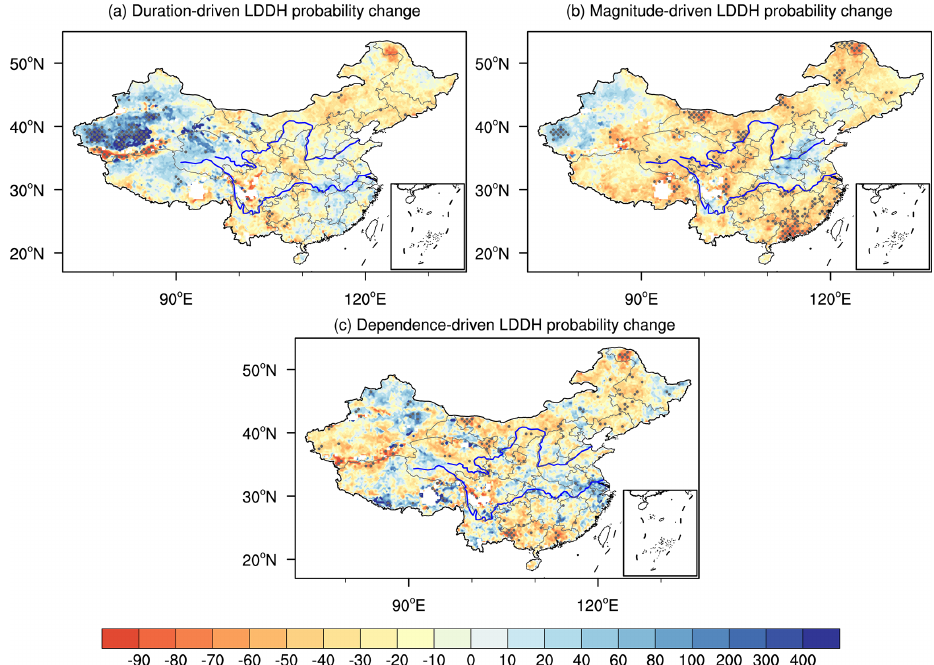
Figure 6. Changes (%) in return periods of compound long-duration dry and hot events between 1988–2014 and 1961–1987 due to changes in the marginal distribution of (a) duration, (b) magnitude, and (c) dependence between duration and magnitude. Statistically significant changes are shown by